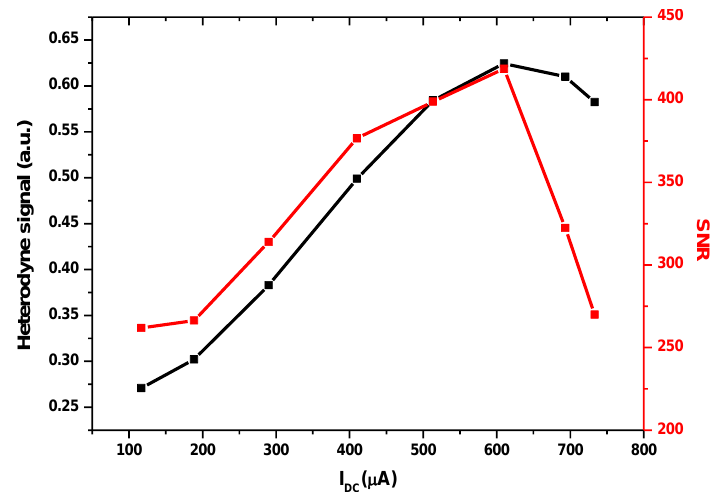
Figure 6. Evolution of heterodyne signal (black square) and SNR (red square) as a function of LO photocurrent.